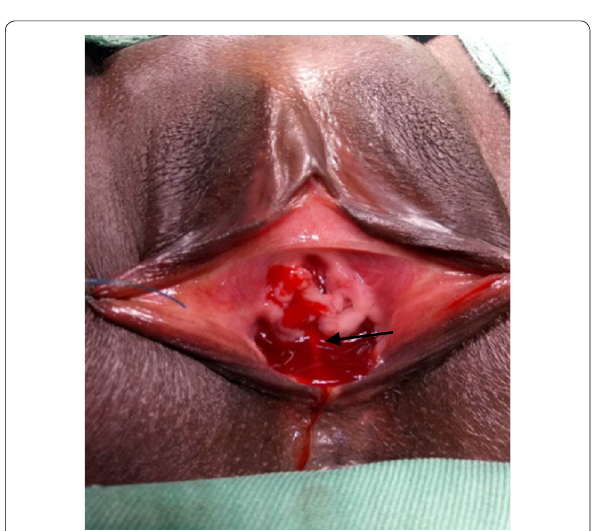
Fig. 2 Vagina dissection with a 2–3‑cm midline incision on the vaginal mucosa overlying the urethral and bladder neck